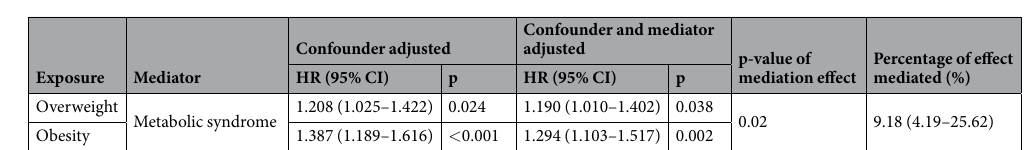
Figure 2. Risk of erosive reflux disease according to combination of body mass index category and the metabolic syndrome ( a ). Risk of erosive reflux disease according to combination of body mass index category and the metabolic syndrome in male ( b ) and female ( c ).